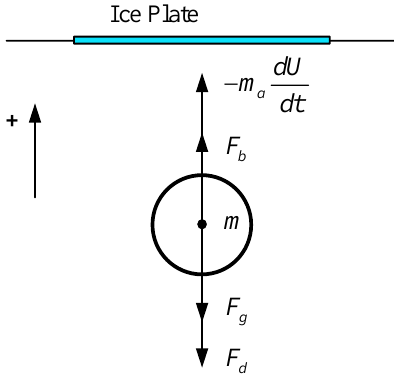
Figure 1. Sketch of the problem.